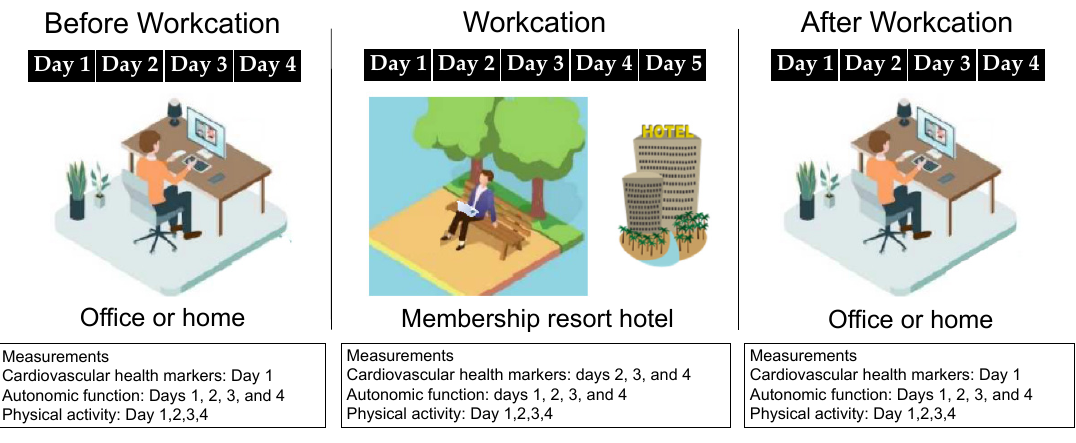
Figure 1. Study design.